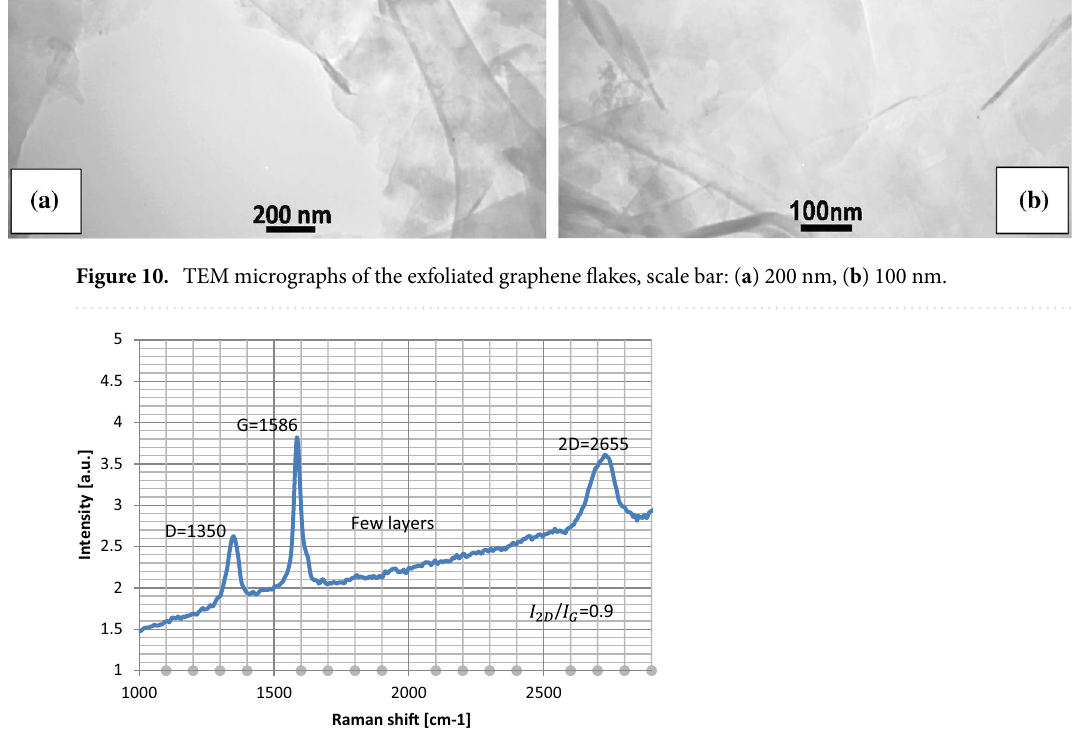
Figure 11. Raman spectrum of dispersed few layer graphene flake exfoliated using ultrasonic